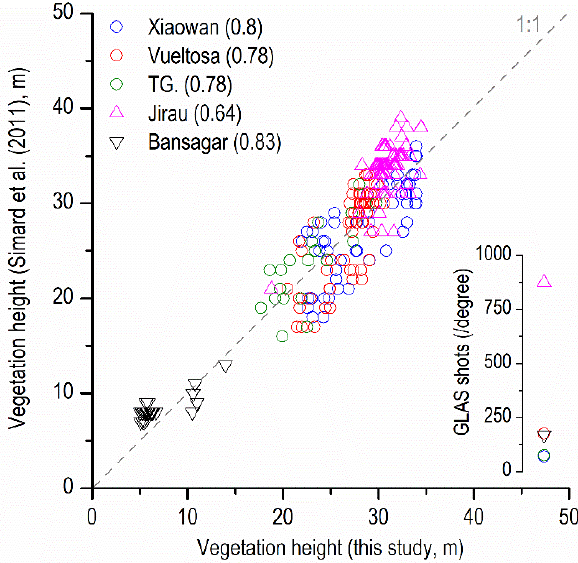
Figure 3. Comparison of vegetation height rasters over analysed reservoirs in this study with a global scale canopy dataset. Correlation coefficients r are reported in parenthesis. Density of GLAS shots (per degree) used for the tree regression procedure by Simard and Pinto [44] for each reservoir is also presented.